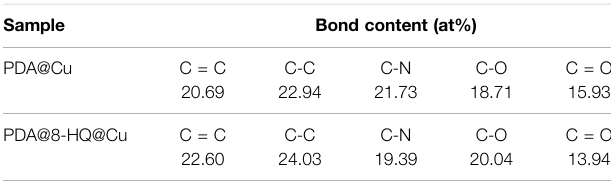
TABLE 1 | Bond composition and content of C = C, C-C, C-N, C-O, and C = O of C 1s. Sample Bond content (at%)